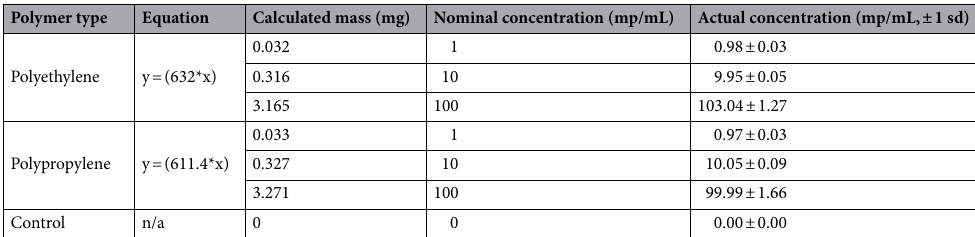
Table 1. Validation of ice cap dosing concentrations. Actual concentrations (n = 3) of polyethylene and polypropylene microfragments (150–300 μm) closely matched their nominal concentrations using the ice cap dosing method. Calculated masses for each nominal concentration were determined by linear regression dosing equations (see Fig. 4).